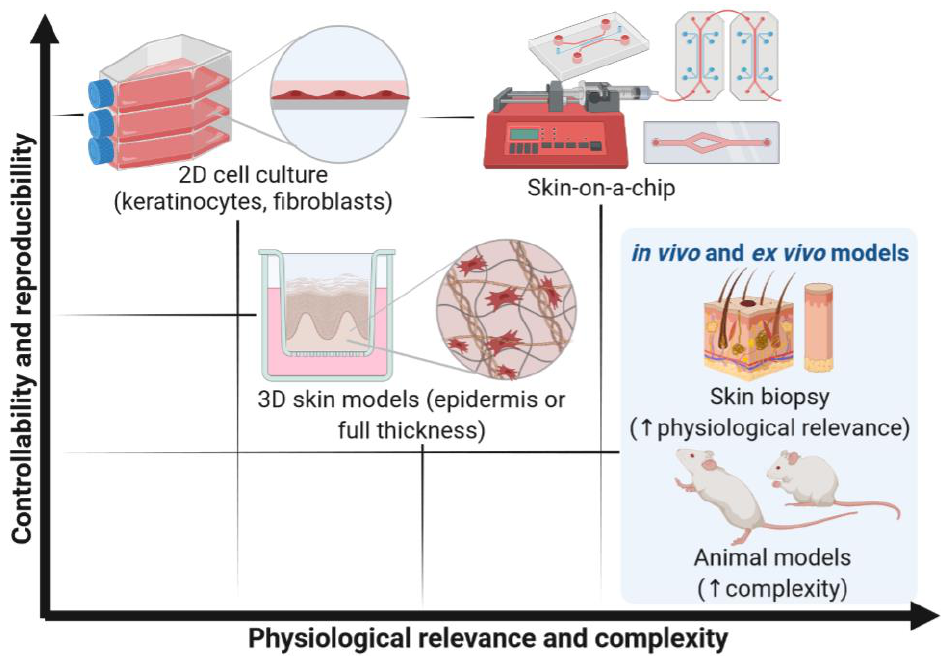
Figure 1. Methods used for preclinical studies of skin-targeted drugs. Comparison between the different methodologies regarding controllability and reproducibility as well as physiological relevance and complexity. The figure highlights the potential significance of organ-on-a-chip (OoC) technology to provide a reproducible and physiologically relevant approach to systematically evaluating skin responses.